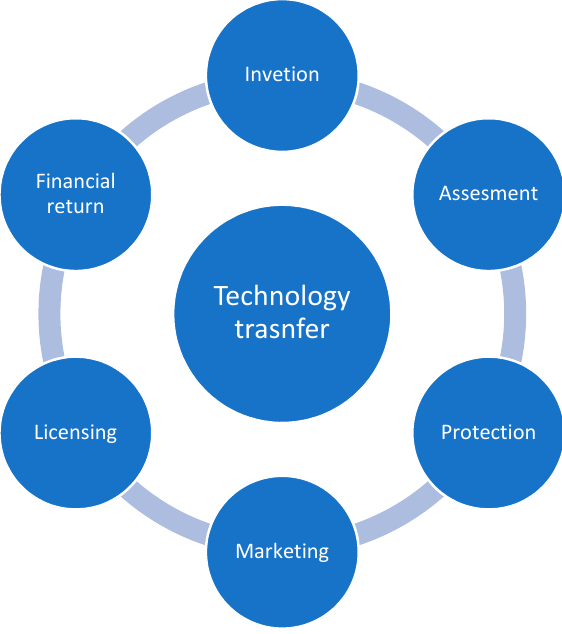
Figure 2. Technology transfer process, source: based on (Vac and Fitiu 2017).